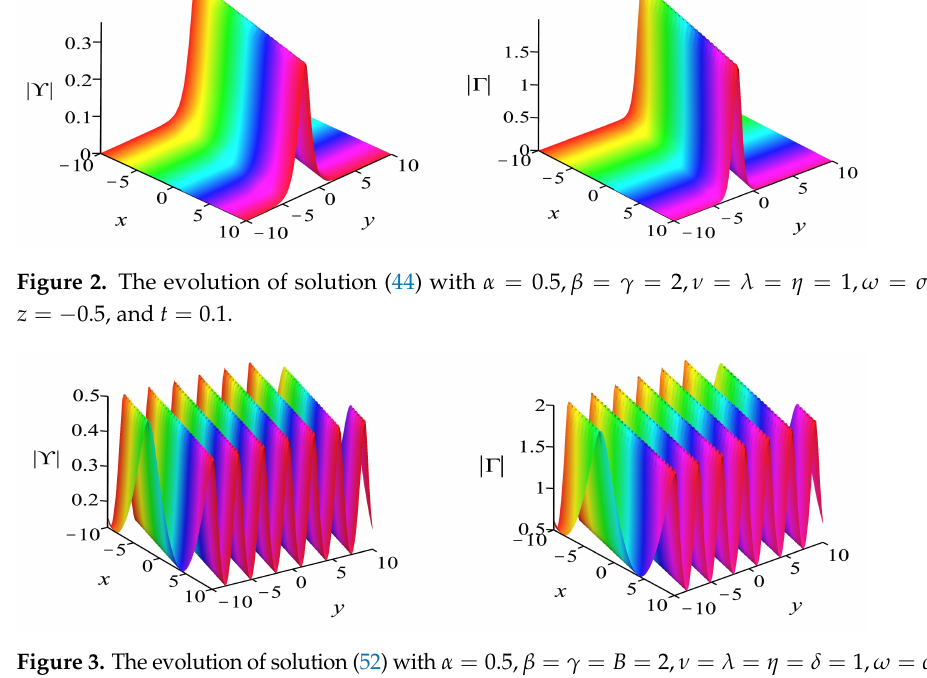
Figure 3. The evolution of solution (52) with α = 0.5, β = γ = B = 2, ν = λ = η = δ = 1, ω = σ = − 2, C = i , z = − 0.5, and t = 0.1.